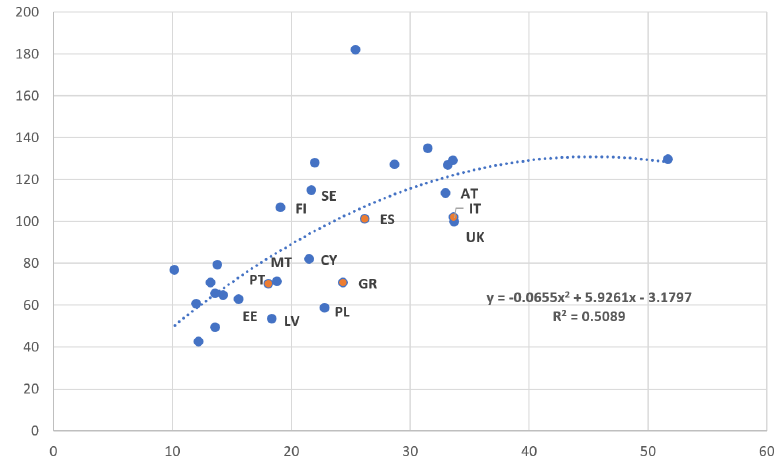
Figure 3: relation between productivity ( y -axis) and percent of underloaded workers ( x -axis), 2015